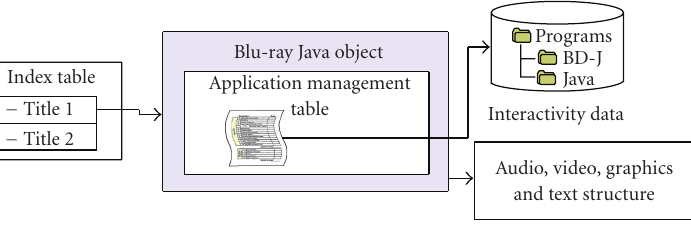
Figure 5: Simplified structure of Blu-ray Java title.